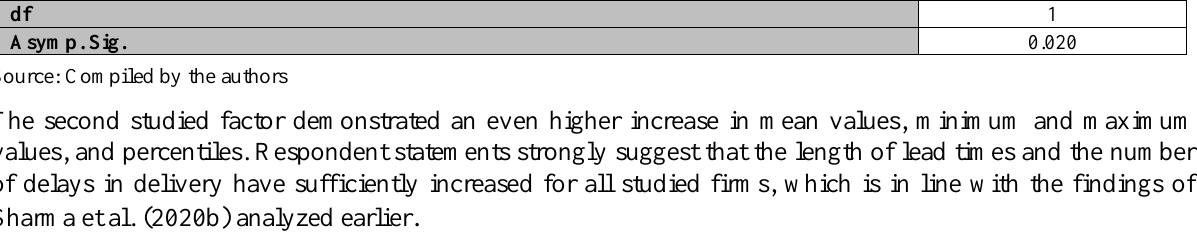
Table 4. Long Lead Times and Delays in Delivery (Descriptive Statistics)